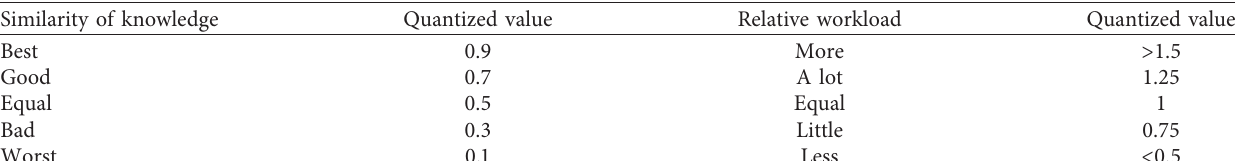
Table 1: Fuzzy evaluation sets of p